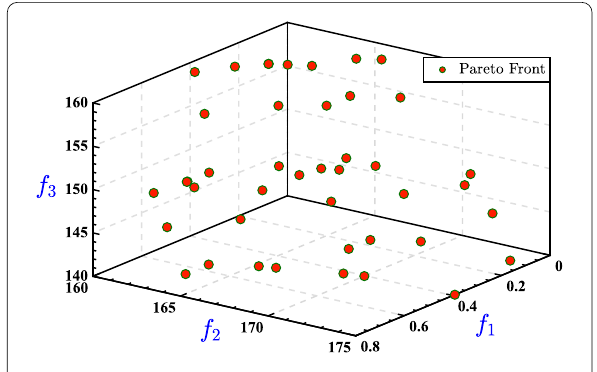
Figure 4 Initial Pareto front